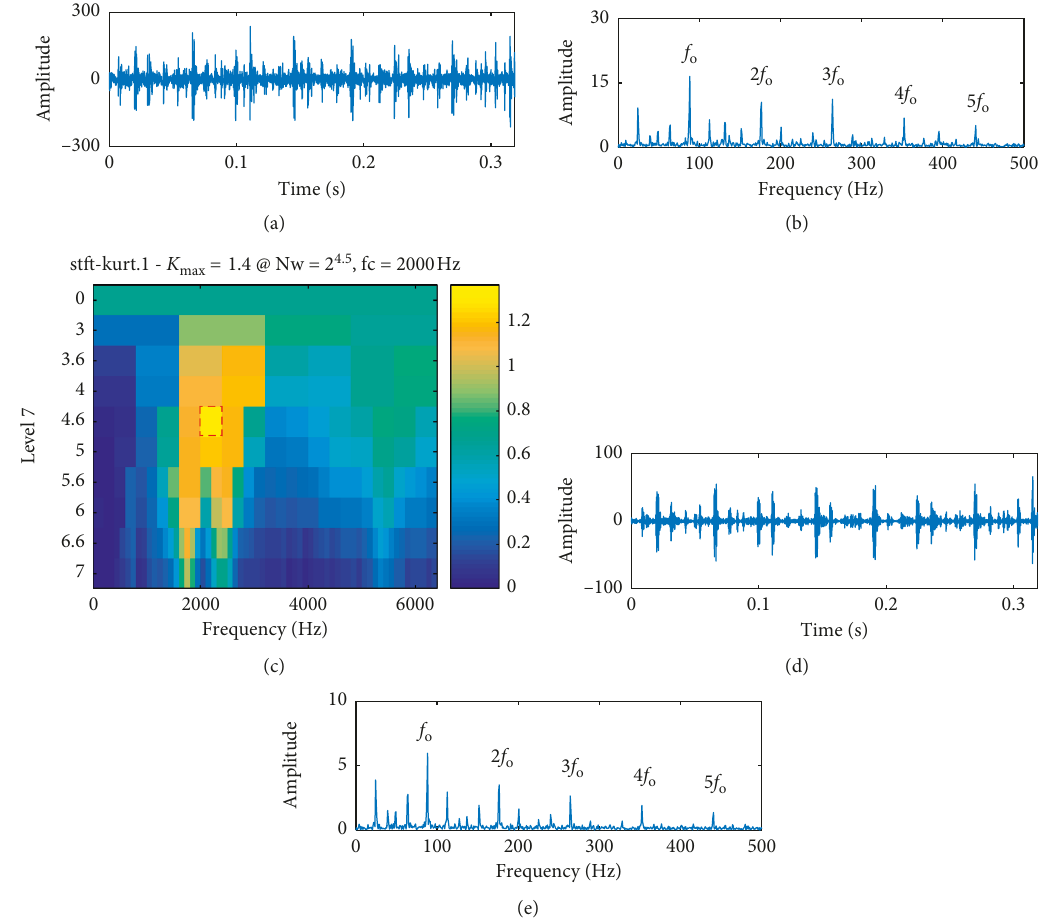
Figure 17: Diagnosis results of the compound fault experimental signal by EEMD-FSK: (a) TW of the reconstruction signal obtained by EEMD; (b) ES of (a); (c) kurtogram; (d) TW of the filtered signal obtained by FSK; (e) ES of